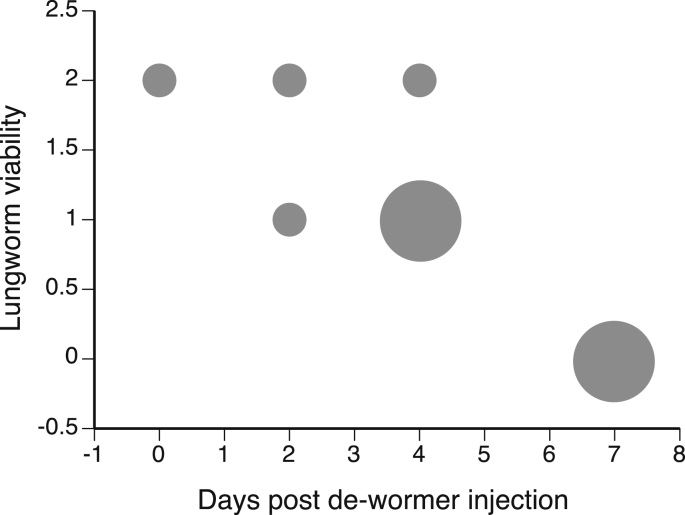
Effects of anthelmintic injection (Ivermectin) on the viability of adult lungworms (Rhabdias pseudosphaerocephala inside the lungs of cane toads (n = 10) hosts over a 7-day period following anthelmintic injection. Lungworm viability scores (see text for definitions) decreased with time since injection. The size of the symbols represents sample size of each score. Two toads had not been treated with anthelmintic when euthanized and were given scores of 0 days post injection.